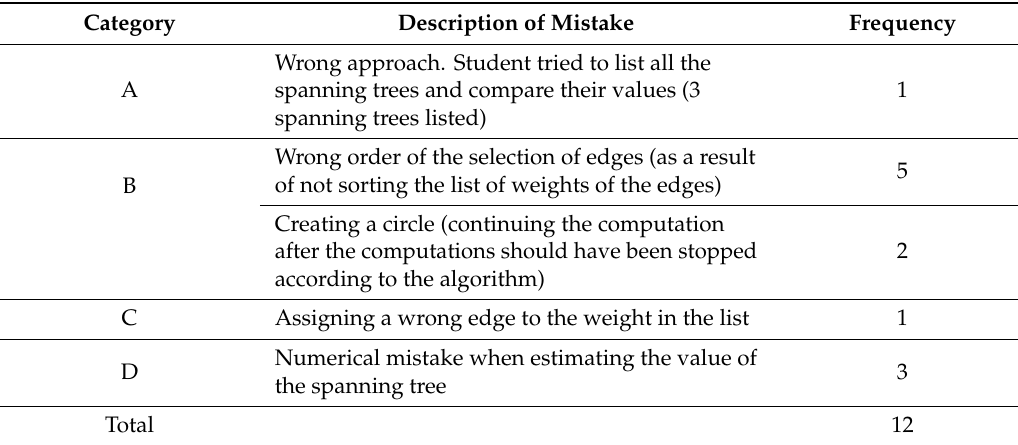
Table 3. Frequencies of mistakes in students’ solutions of the minimum spanning tree problem (source: own